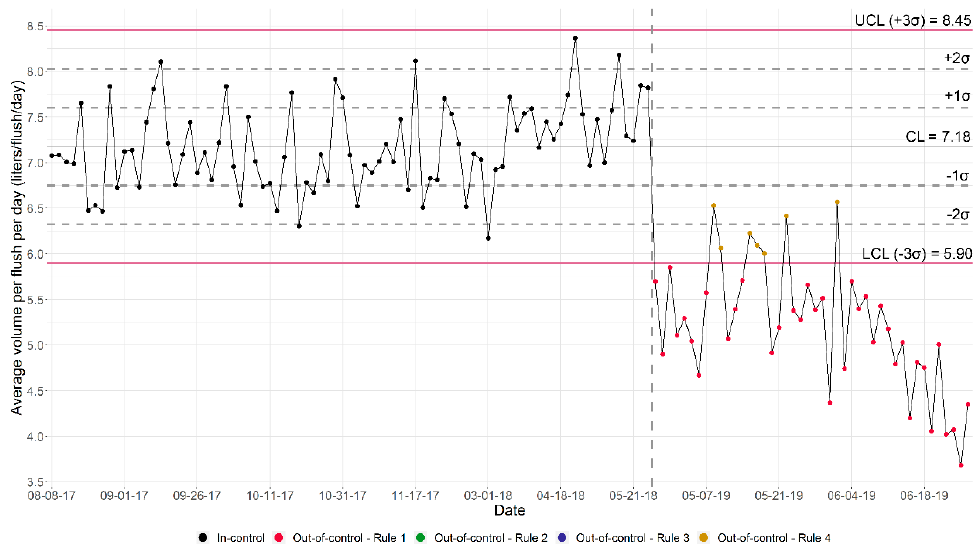
Figure 8. Shewhart Control Chart—Average volume per flush per day (female restrooms).